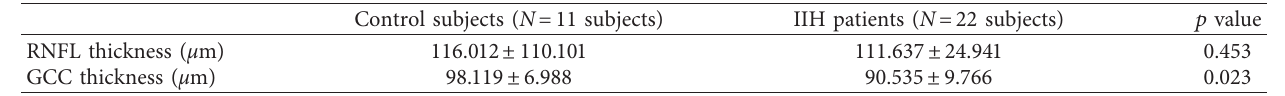
Table 2: . OCT parameters of study patients (mean ± standard deviation).